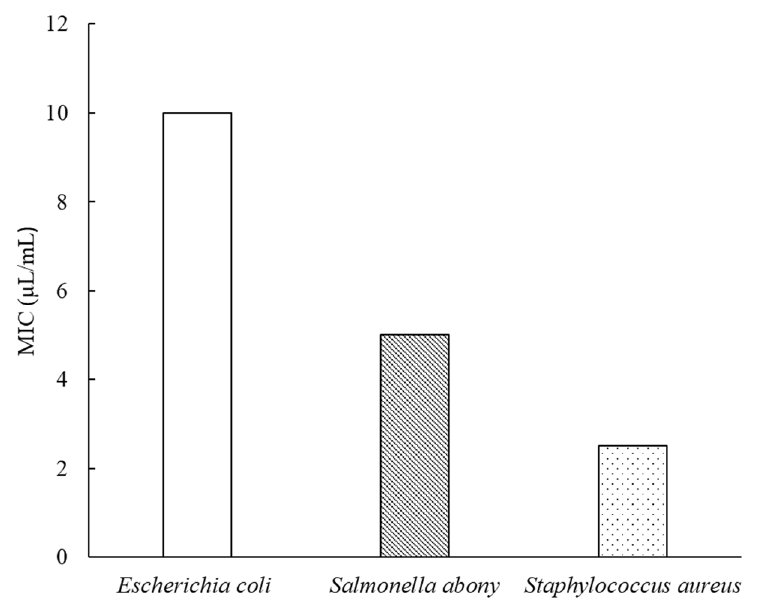
Figure 3. Minimum inhibitory concentrations (MICs) of A. ordosica essential oil against tested bacterial strains.